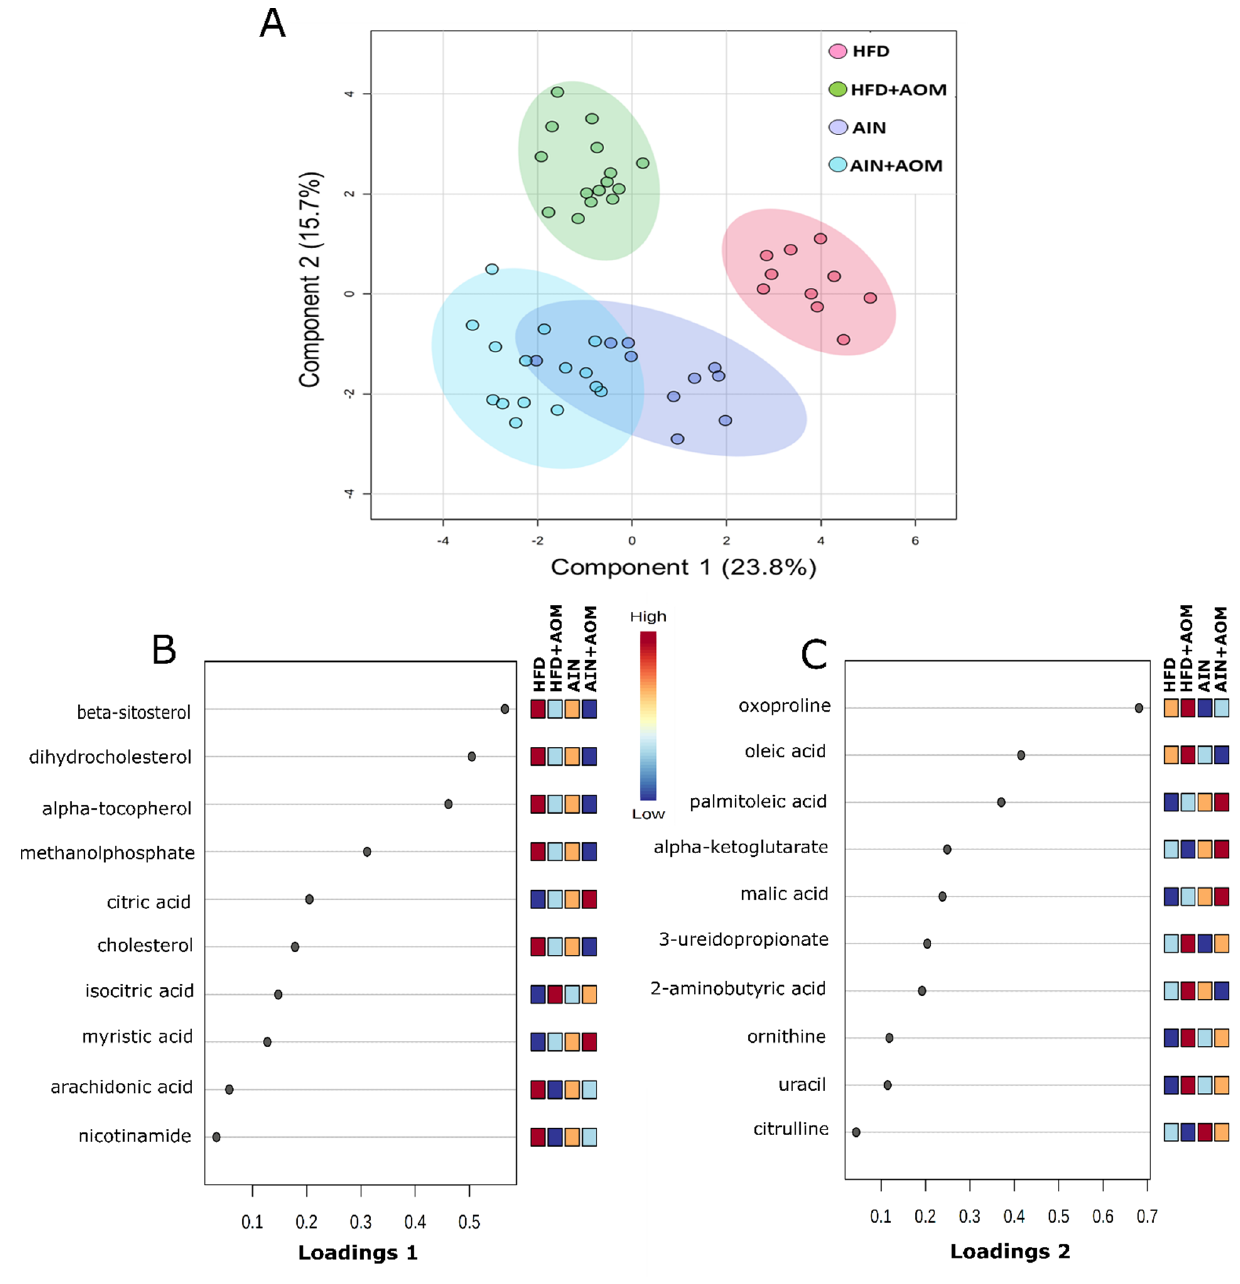
Figure 1. Two-dimensional (2D) sPLS-DA of the 4 experimental groups ( A ) and loading plots of 10 metabolites that are most significant in group separation among the four groups for Component 1 ( B ) and Component 2 ( C ). Mice without AOM treatment (control), n = 10/group (AIN or HFD group). Mice with AOM treatment (AIN + AOM or HFD + AOM group), n = 15/group.